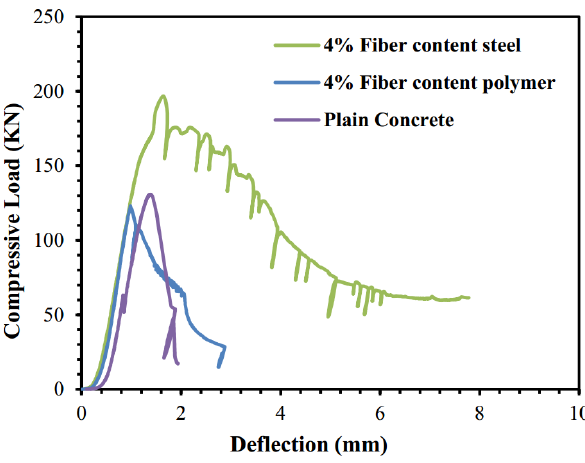
Figure 4: Average Compressive load-deflection curves of the tested